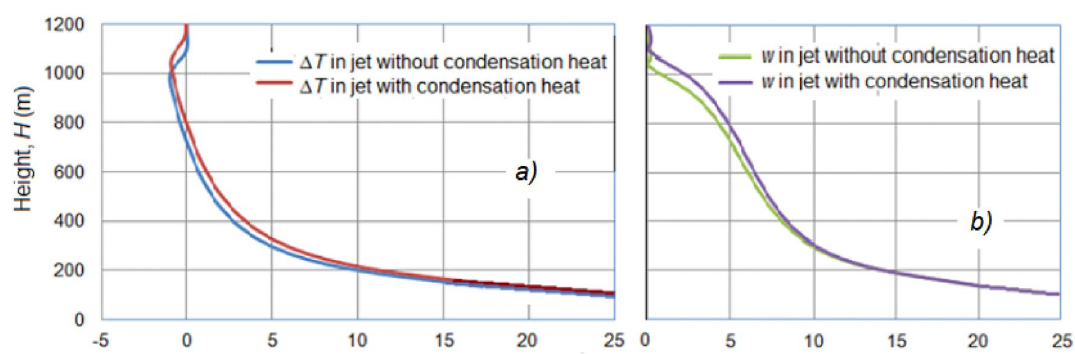
Figure 14. Vertical profiles of temperature excess Δ T (°C) ( a ) and updraft speed W (m/sec) ( b ) in a jet with feeding P C = 5.14 MW and without feeding in a windless atmosphere at γ = 6.5